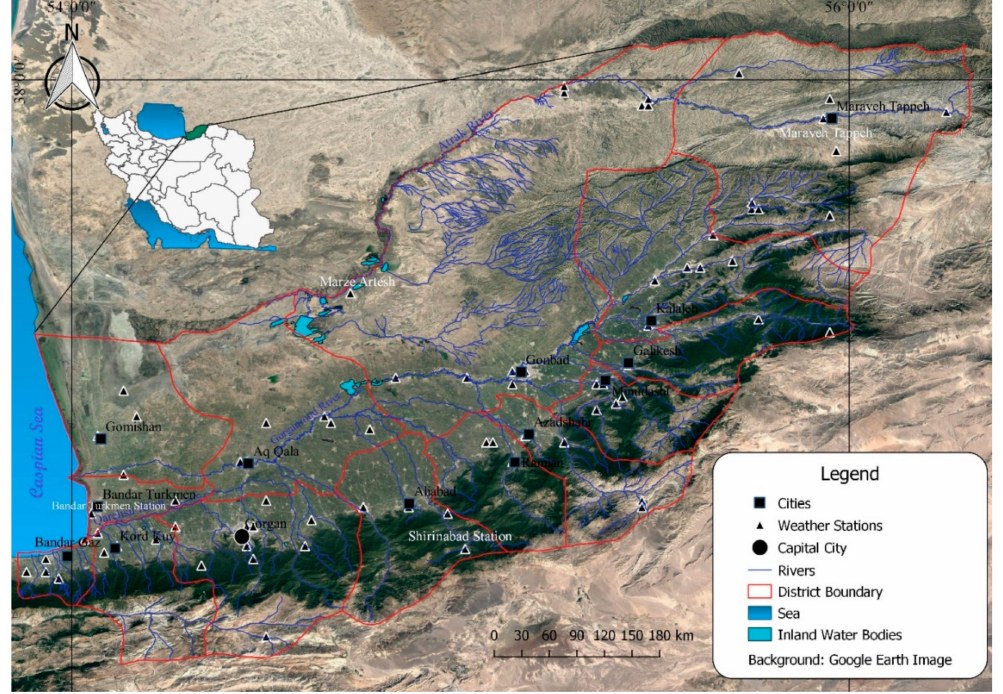
Figure 1. Location of the study area relative to Iran’s boundary along with the districts of Golestan